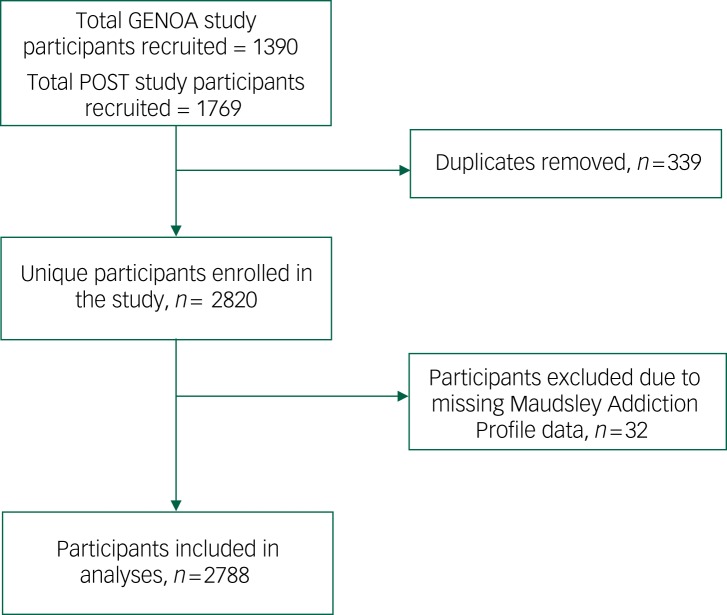
Study flow diagram.